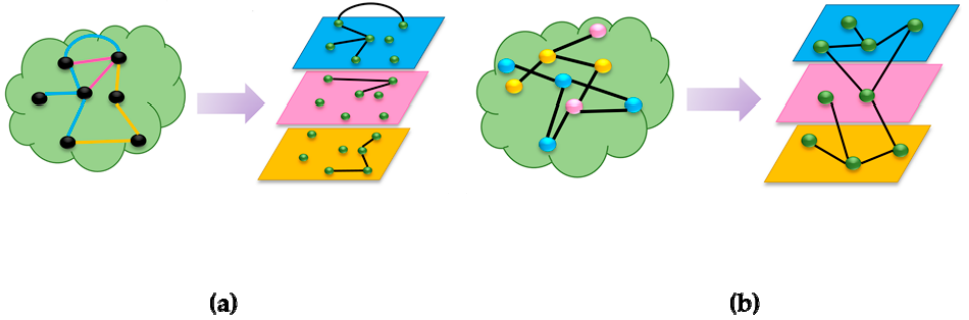
Figure 1. Two categories of multilayered graphs. ( a ) Edge-colored Graphs (ECG) ( b ) Node-colored Graphs (NCG).